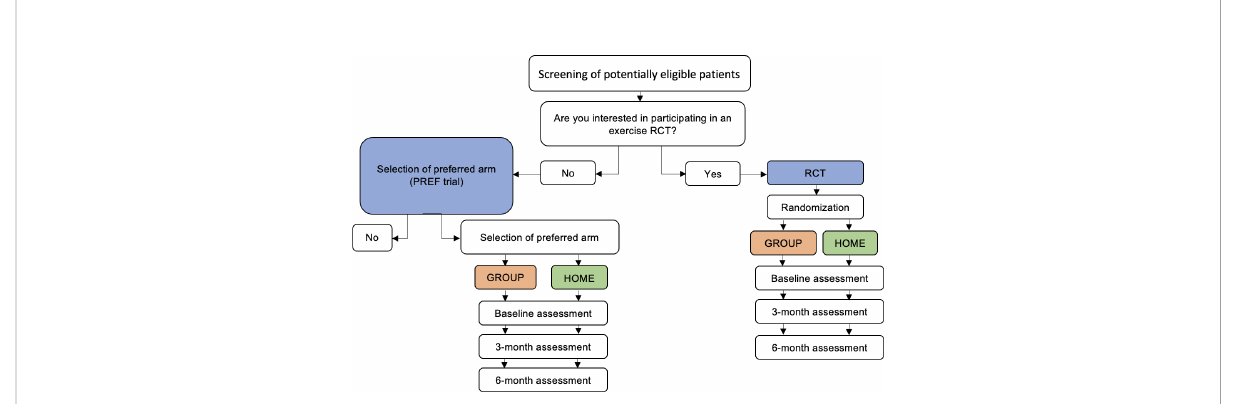
FIGURE 1 Schema of preference-based trial and RCT. RCT, randomized controlled trial; PREF, preference. Blue denotes comparison of the selection effect (PREF vs. RCT). Orange and green denote the comparison of the treatment effect (GROUP-PREF + GROUP-RCT vs. HOME-PREF +